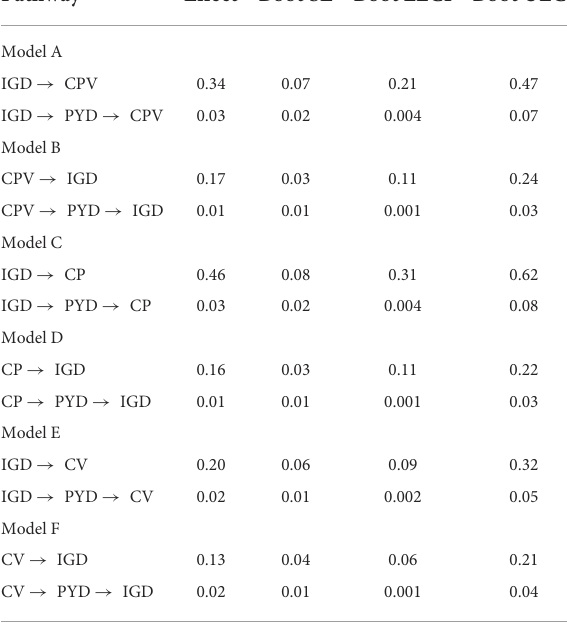
TABLE 2 Summary of the direct and indirect